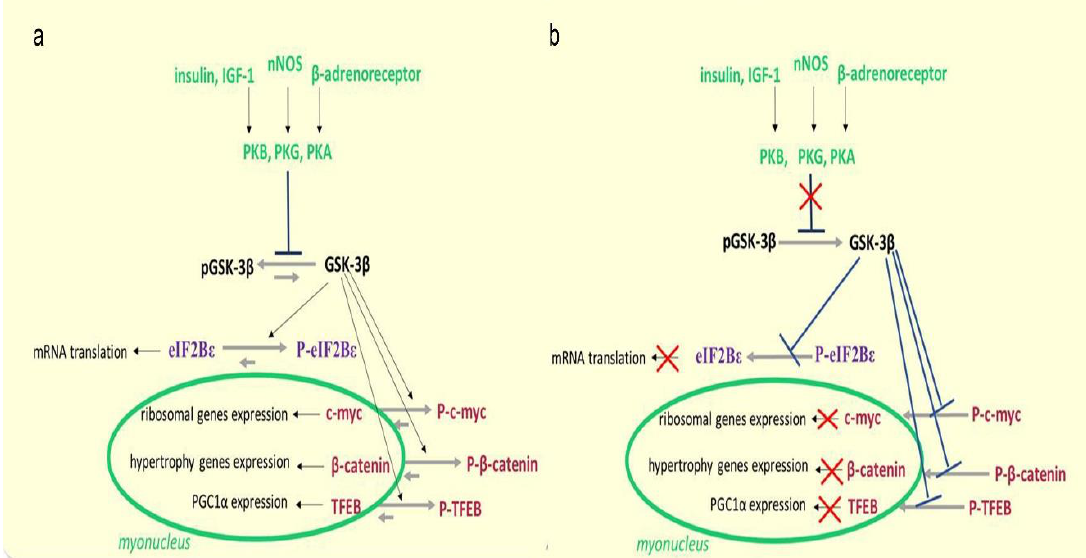
Figure 5. GSK3β as a negative integrator of signaling pathways in muscle fibers and its role under unloading conditions. ( a ) GSK3β in an active skeletal muscle fiber. Following Ser9 phosphorylation by AKT (insulin/IGF-1 - dependent signaling), protein kinase G (NO-synthase/cGMP signaling) or protein kinase A (β-AR/cAMP signaling) GSK3β gets inactivated and does not interfere with 1) initiation of mRNA translation via eIF2Bε, 2) β-catenin, c-Myc and transcription factor TFEB nuclear translocation and, accordingly, expression of hypertrophic genes, 3) the synthesis of ribosomal RNAs and peroxisome proliferator-activated receptor-gamma co-activator 1 (PGC-1). ( b ) GSK3β at the early stage of unloading. Under reduced AKT (Ser473) phosphorylation and NO production, GSK3β (Ser9) phosphorylation is reduced, and GSK3β activity is increased. Therefore, GSK3β inhibits mRNA translation initiation and nuclear translocation of the regulators of transcription and expression of the key genes.